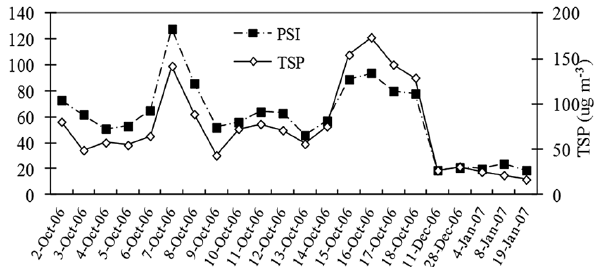
Figure 2. Temporal changes in total suspended particulate matter (TSP) concentrations and Pollutants Standard Index (PSI) during haze (October 2006) and clear (December 2006–January 2007) days in St. John’s Island in Singapore.